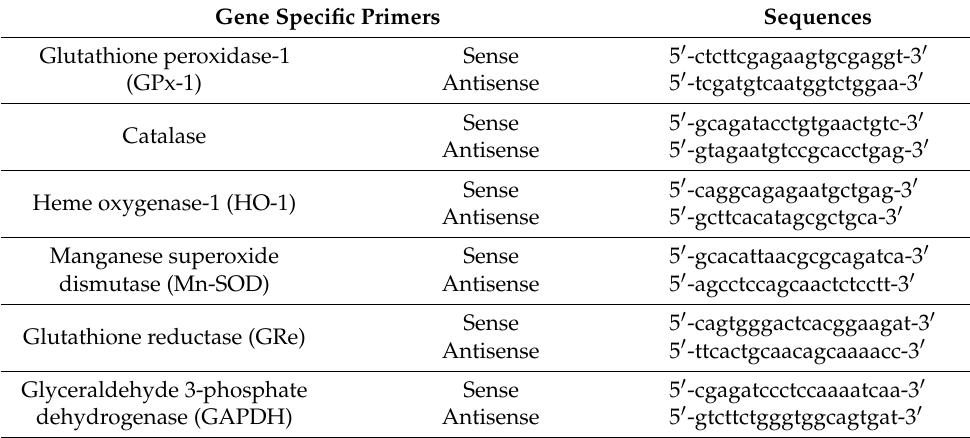
Table 2. The specific primers for human antioxidant genes. Gene Specific Primers